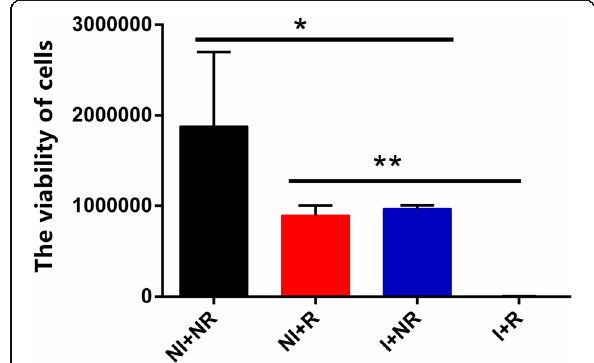
Fig. 7 Viability of cells that were treated differently. Cells without irradiating had greater viability than NIR-irradiated cells ( P < 0.05).